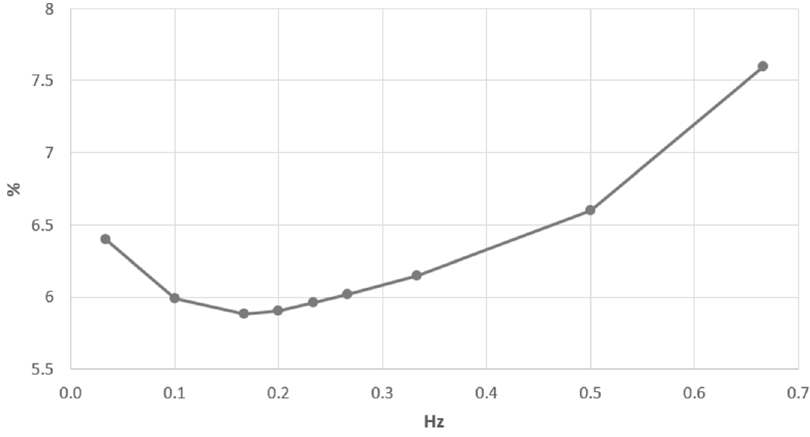
CO from the artificial respiratory rate (ARR). Figure 4. Alveolar concentration of CO 2 2 from the artificial respiratory rate